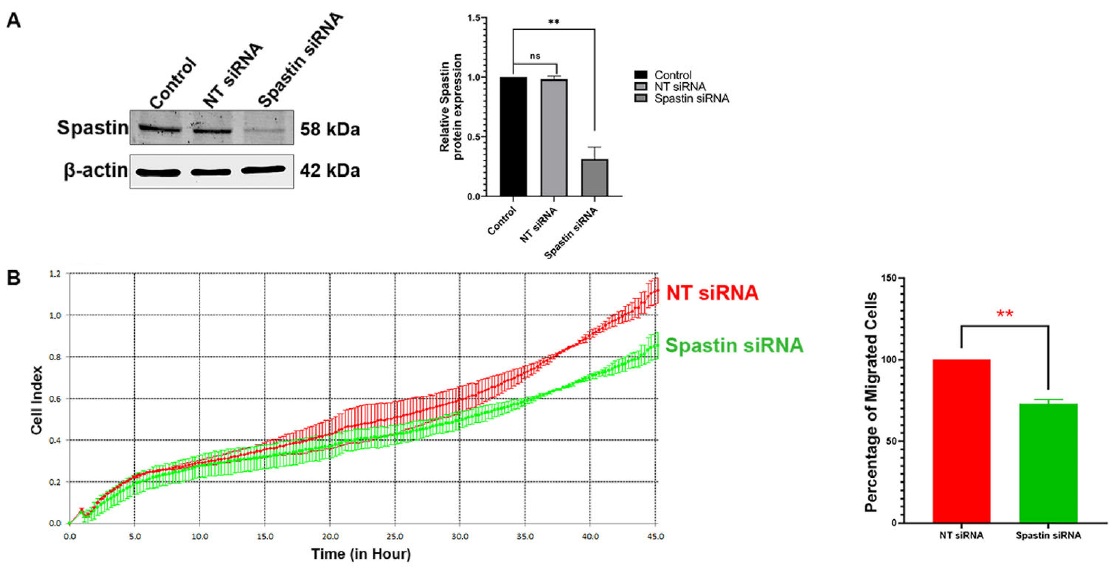
Figure 2. Real-time monitoring and measurement of T98G cell motility upon Spastin depletion. ( A ) Depletion of Spastin expression upon siRNA treatment was analyzed by Western blot (WB). T98G cells were transfected with either Spastin-specific or non-target siRNA for 48 h. Then, Spastin expression was detected with WB using a specific antibody to Spastin. Representative WB is shown and relative densitometric values of Spastin/ β -actin are reported in the right panel. Molecular weights of the proteins are reported in kilodalton (kDa). ( B ) xCelligence impedance-based system was used for the migration analysis. Representative result is shown in the left panel. Results were statistically analyzed by t-test from two independent biological replicates containing three independent technical replicates. Data are represented as mean ± SD. n.s. p > 0.05, and ** p < 0.01 (right